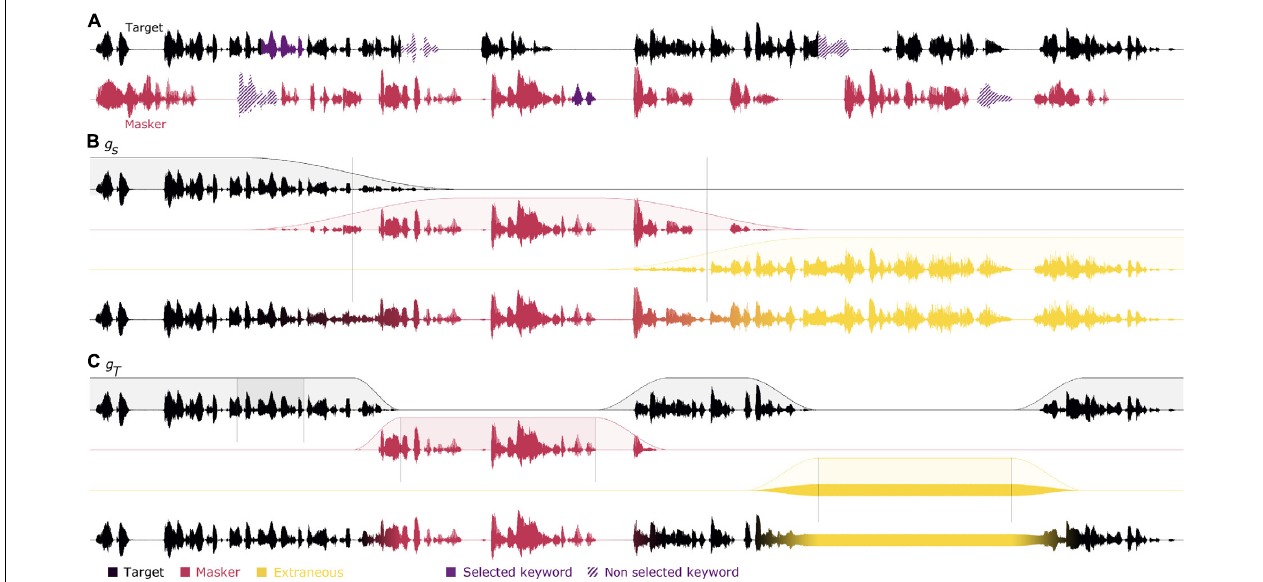
FIGURE 1 | Creation steps of inferred stimuli. Panel (A) represents an example of a trial where the target is in black and the masker is in red. In this example, the participant has answered the first target keyword (highlighted in purple), the second masker keyword and the third extraneous keyword. The unselected keywords are shown with a hatched pattern. (B) The three segments are built according to the participant’s answer with an attention switch of 3 s and the extraneous segments filled with the mixture of the target and masker (i.e., method h + , in yellow). The attention scopes are interpolated with the segment method g S . The three segments are then added together. (C) The three attention scopes are built according to the participant’s answer with an attention switch of 1 s and the extraneous sections filled with noise ( h N ). When no behavioral information is known, the attention scope is filled with the target (i.e., g T ). The three parts are then added together.